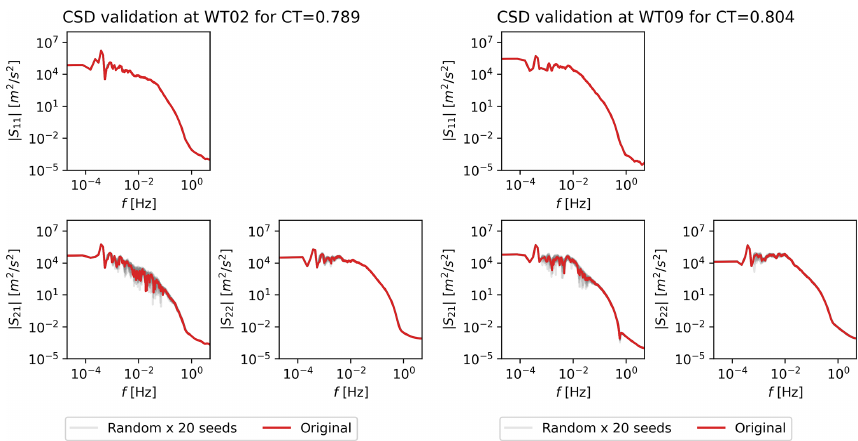
Figure 10. Comparison of CSD of original and stochastic realizations evaluated at high C T (a member of the training dataset) for WT02 and WT09.